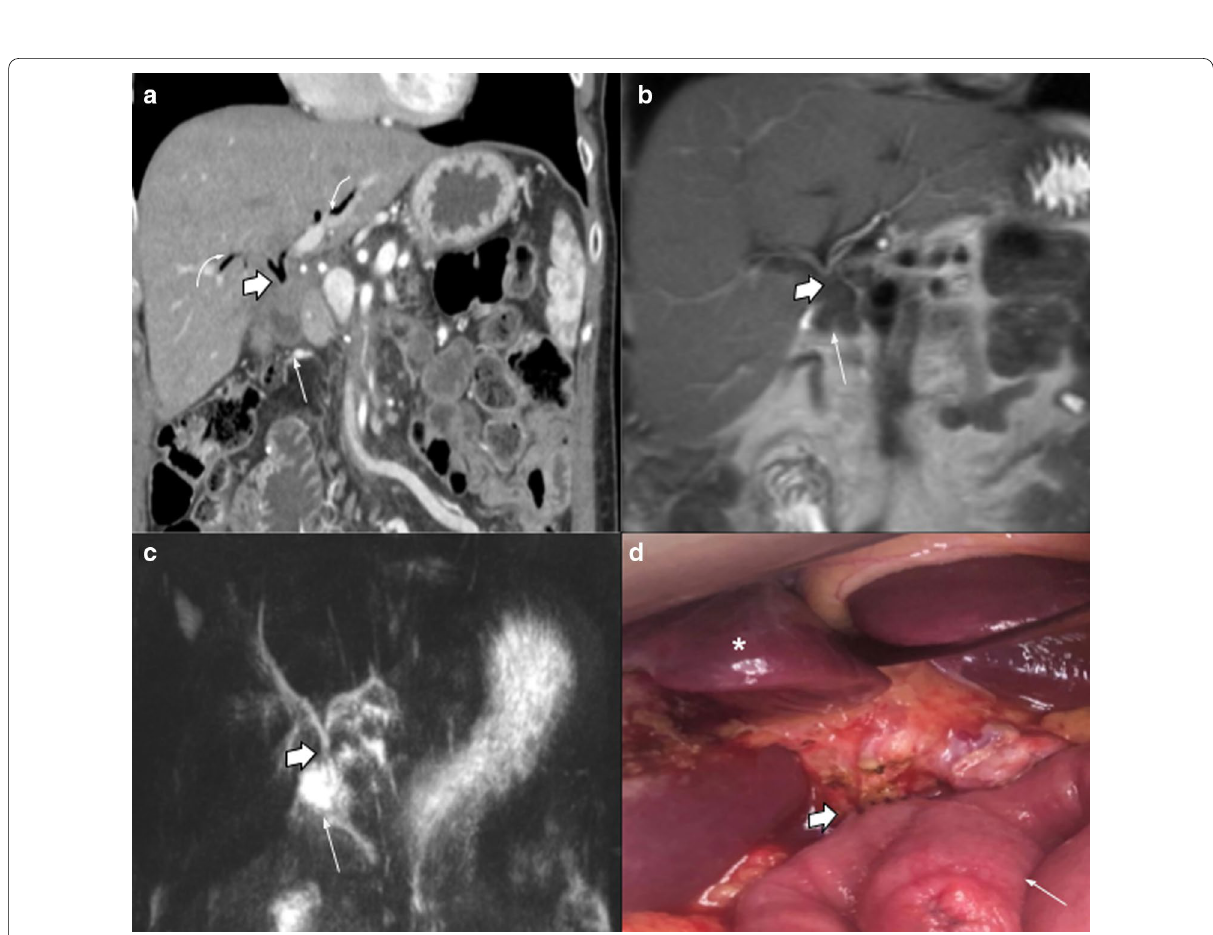
Fig. 4 Hepaticojejunostomy. Radiologic-Surgical correlation: ( a ) Contrasted Coronal CT scan. ( b ) Coronal T2WI MRI image. ( c ) MRI Cholangiography. ( d ) Surgical photograph References: Partially collapsed afferent limb (white straight arrow). Pneumobilia (white curved arrow). Hepaticojejunostomy (thick arrow). Liver